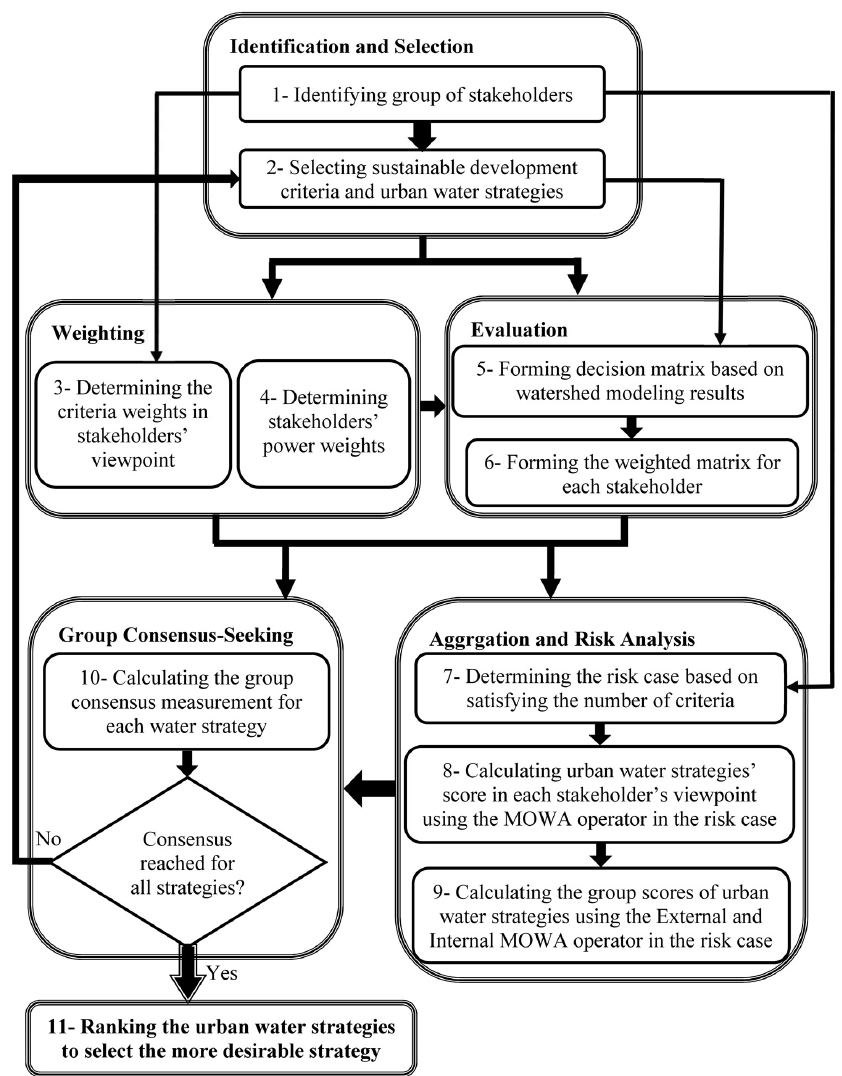
Figure 1. Proposed risk-based consensus-based group decision support system (GDSS) process for the integrated urban water management (IUWM) . MOWA: modified ordered weighted averaging. In the process, first, 𝑚 (cid:4593) initial water strategies are scored by each of the 𝑝 stakeholders. Additionally, 𝑛 (cid:4593) initial criteria are weighted by each of the 𝑝 stakeholders. Accordingly, 𝐶 (cid:4593) = (cid:4593) ,…, 𝐶 (cid:4593) } is assumed as the set of initial criteria; 𝑆 (cid:4593) = {𝑆 (cid:2869)(cid:4593) ,…, 𝑆 {𝐶 (cid:2869)(cid:4593) ,…, 𝐶 (cid:3036) (cid:4594) (cid:3041) (cid:4594)